Question: Write a descriptive caption for this figure.
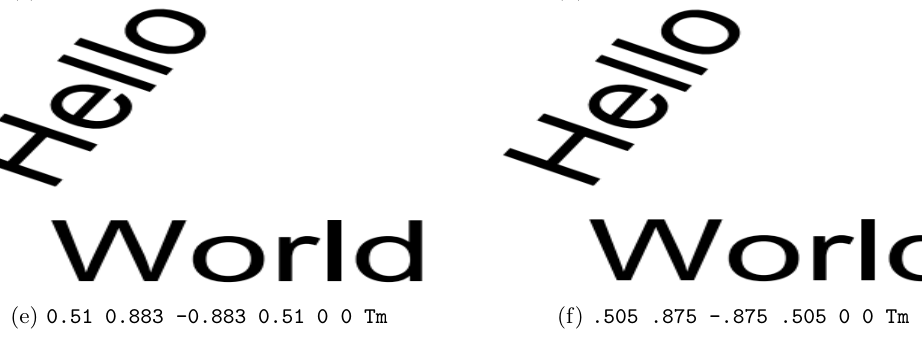
Answer: Tm Operator - control, 20%, 10%, 5%, 2%, 1% (5-10%)